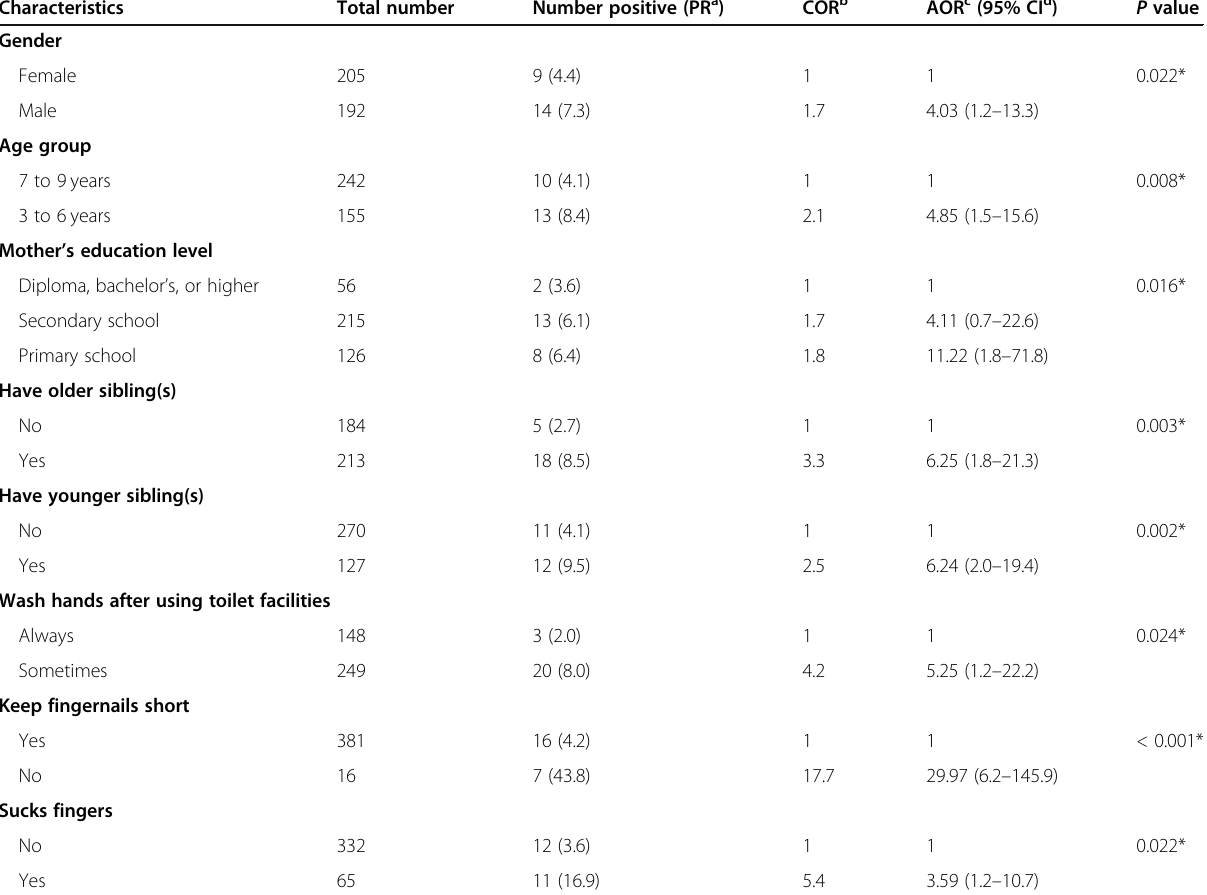
Table 2 Multivariate analysis of risk factors associated with Enterobius vermicularis infections among the study participants